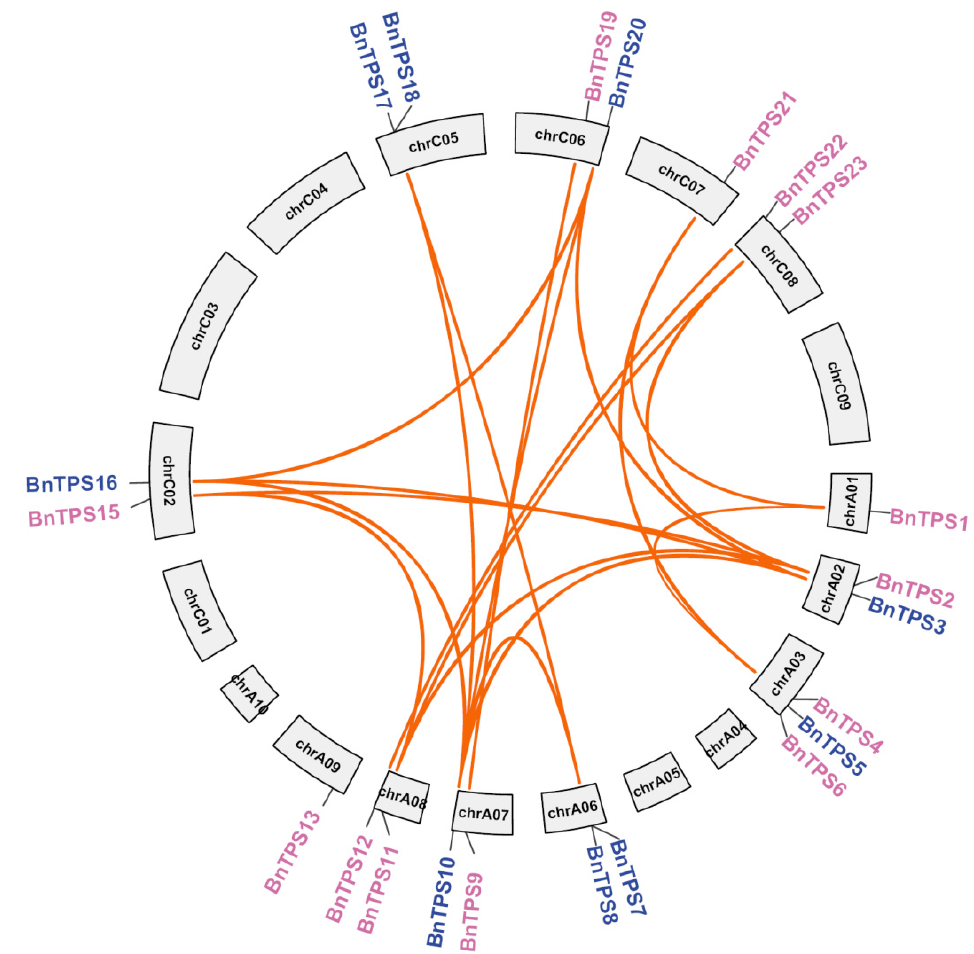
Figure 2. The duplicated BnTPS gene pairs. The genes from the two groups are indicated in pink and blue colors. The orange lines link the paralogous BnTPS gene pairs.